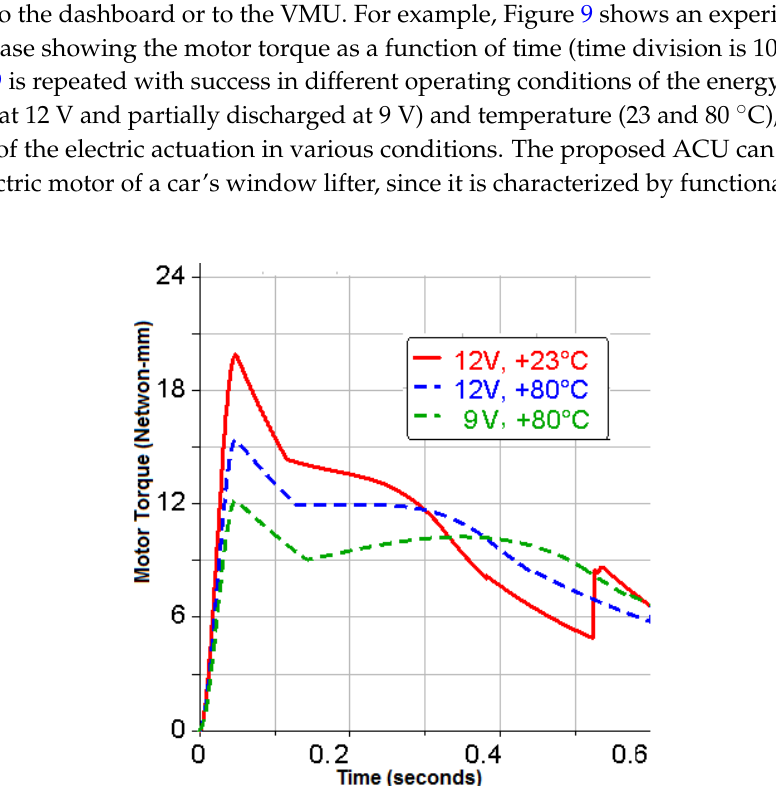
Figure 9. Motor torque during a latch release at different operating conditions of the energy backup source.